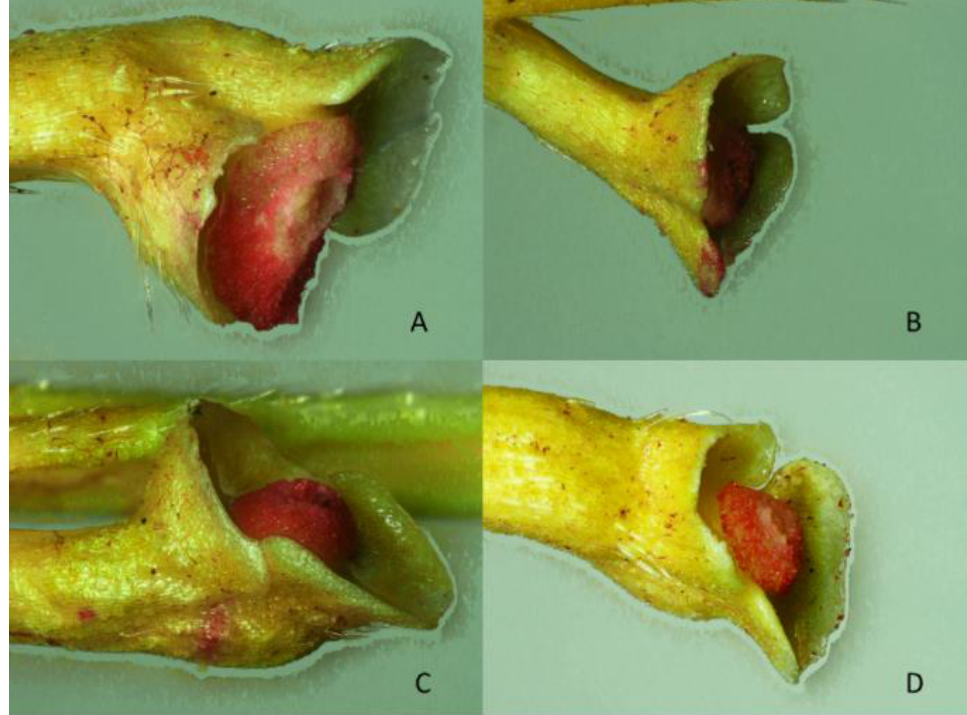
Figure 1. Shape of the separation pileus. ( A , B ) = flat shape; ( C , D ) = prominent shape. Separation pilei were stained with a safranin solution.